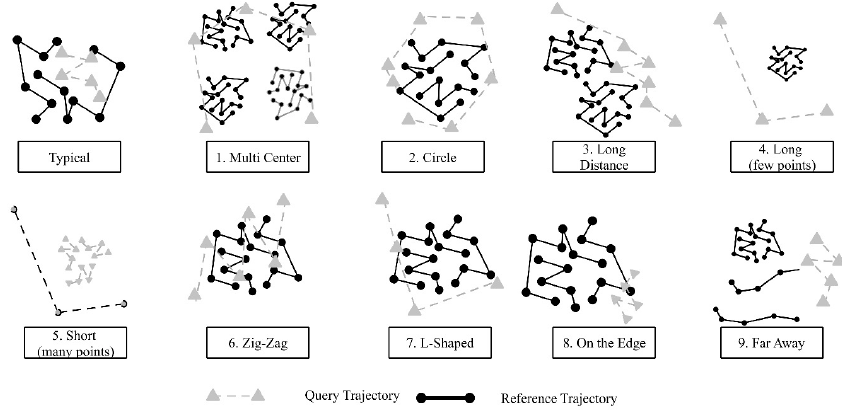
Figure 7. Different query trajectory patterns and shapes.